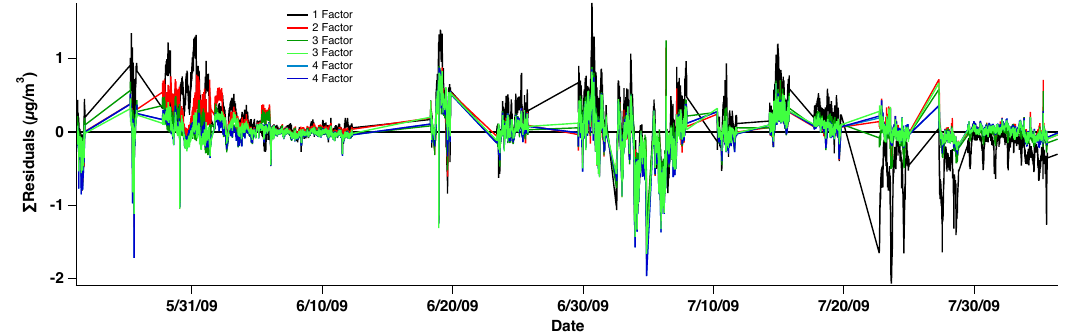
Fig. A3. Sum of the residuals for 1, 2, 3, and 4 factor solutions.